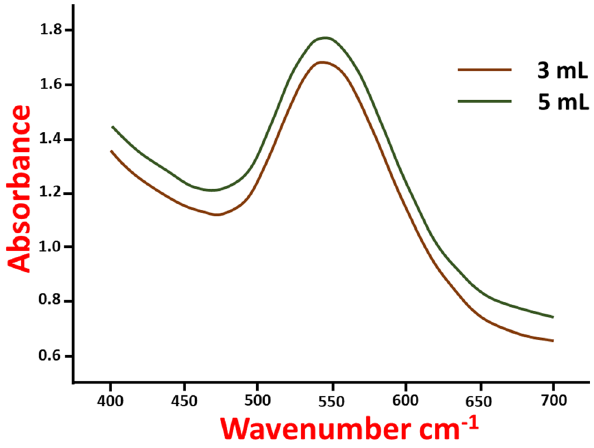
Figure 1: UV - visible absorption of